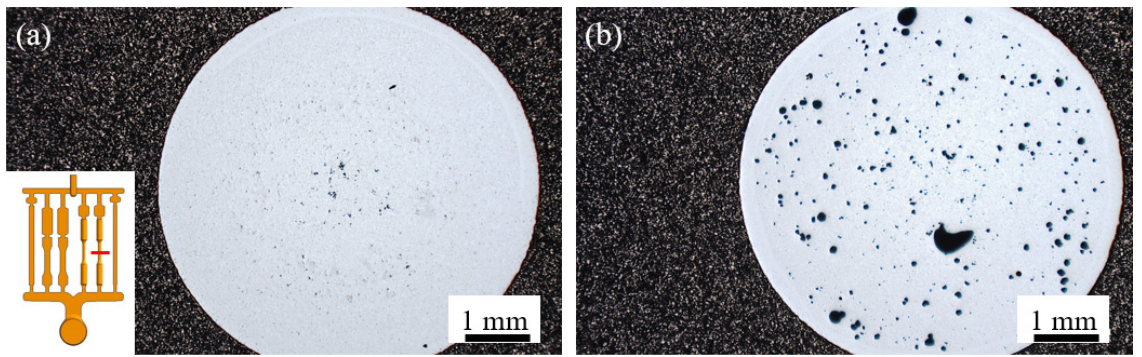
Figure 6. Optical micrographs of ( a ) the as-cast alloy and ( b ) the alloy after the solution treatment 540 °C for 90 min.